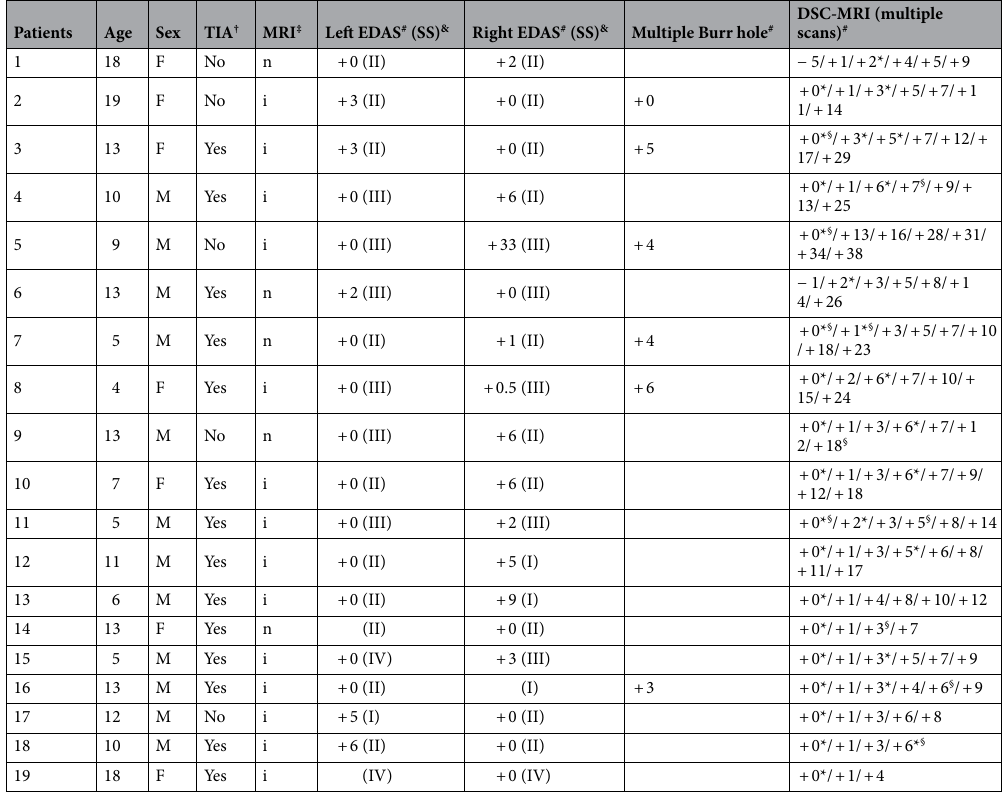
Table 1. Patient demographics. † Patient presents with transient ischemic attack (TIA). ‡ MRI imaging findings: no stroke (n), ischemic (i), or hemorrhage (h). & Suzuki stage (SS). # The action time in i months after the first surgical operation (assigned with a ‘ + i ’ timestamp) of left encephalo-duro-arterio-synangiosis (EDAS), right EDAS, or burr hole operation. *DSC-MRI scanning was performed a few days before a surgical operation.